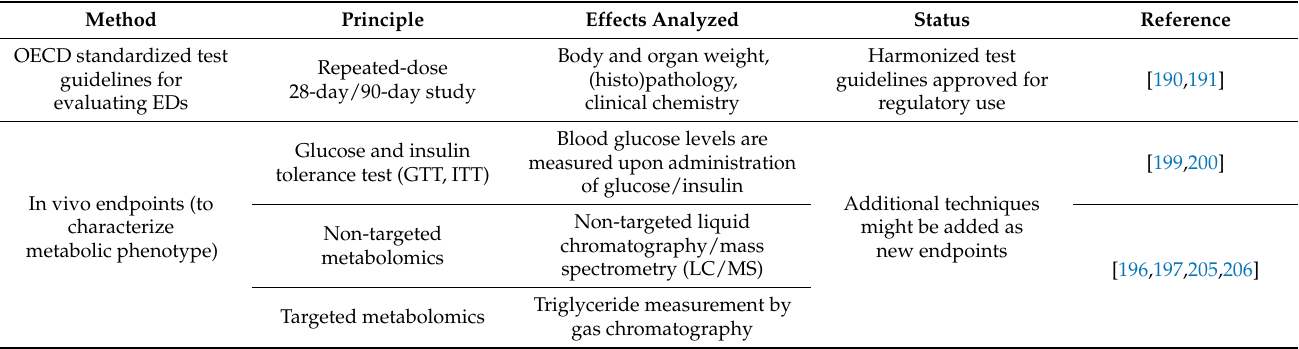
Table 3. Validated or suggested test